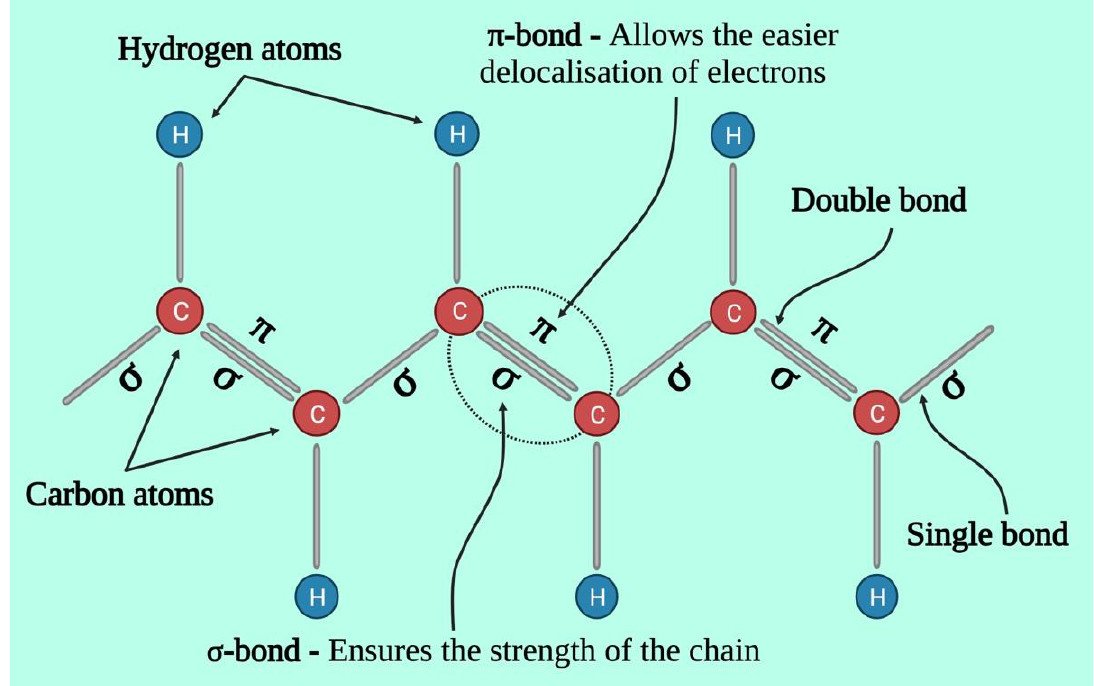
Figure 2. Structural representation of conductive polymer backbone.